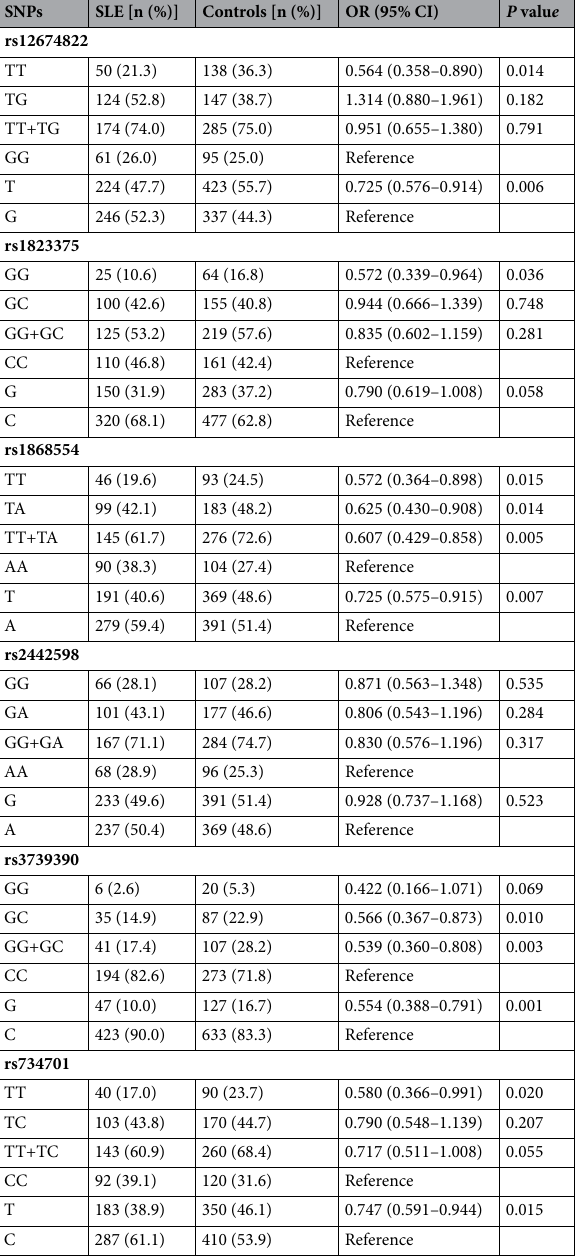
Table 3. Allele and genotype frequencies of six SNPs in the Ang2 gene in SLE patients and healthy controls. SNP, single-nucleotide polymorphism; SLE, systemic lupus erythematosus; OR, odds ratio; 95% CI, 95% confidence